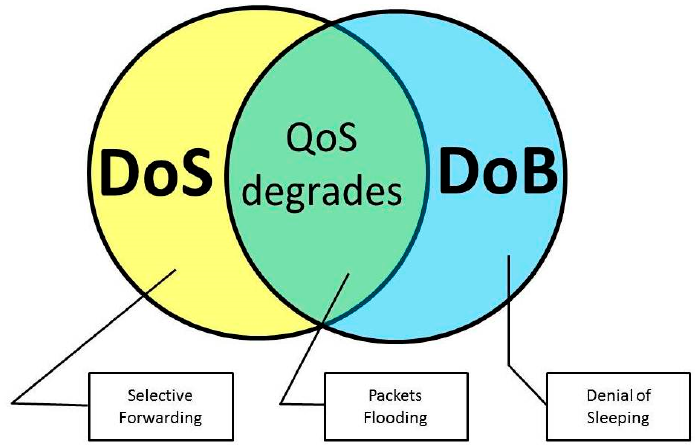
Figure 1. Venn diagram representation of the denial-of-service (DoS) and depletion-of-battery (DoB) attacks interrelation.